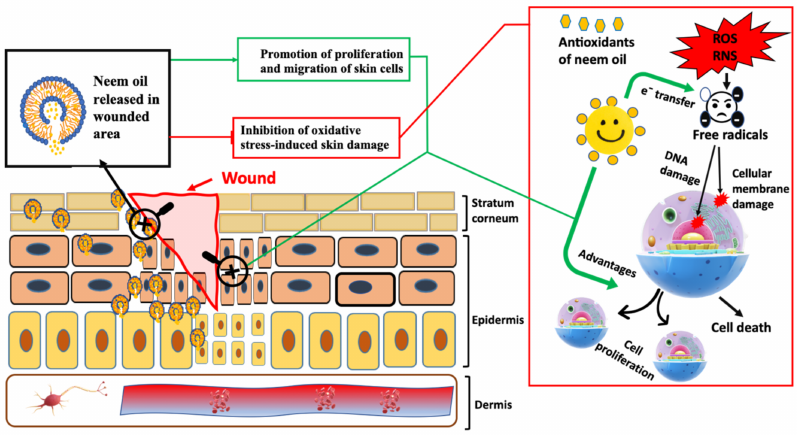
Figure 8. Schematic representation of the antioxidant activity of neem oil containing